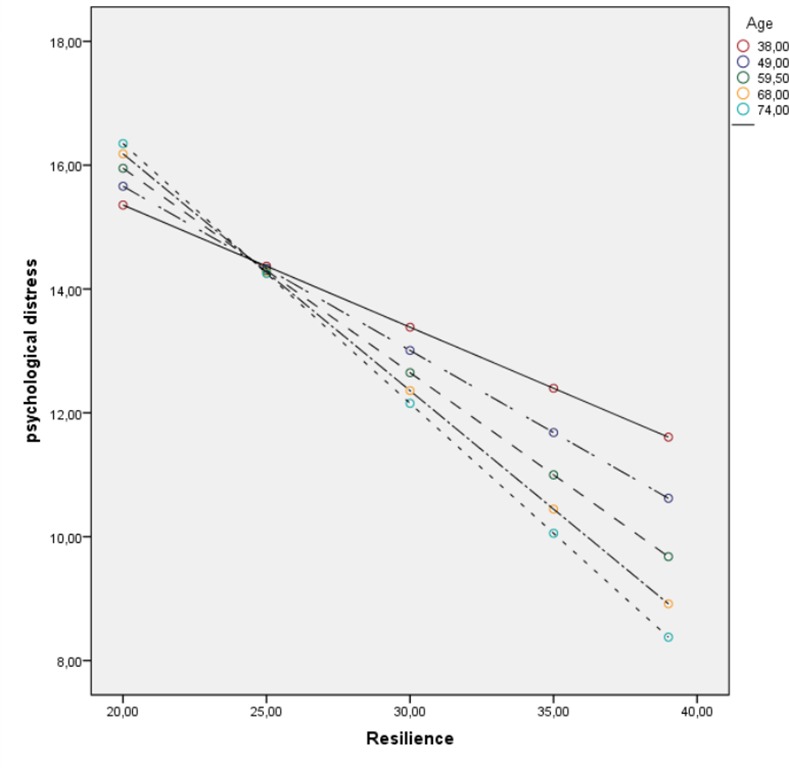
Moderating effect of age on the relationship between resilience and psychological distress.The moderator effects by age showing that compared to younger patients, older patients with equivalent levels of resilience (measured by CD-RISC 10) have lower levels of psychological distress (measured by RSCL). Note. The values of age represent the 10th, 25th, 50th, 75th and 90th percentiles in the sample distribution of age.